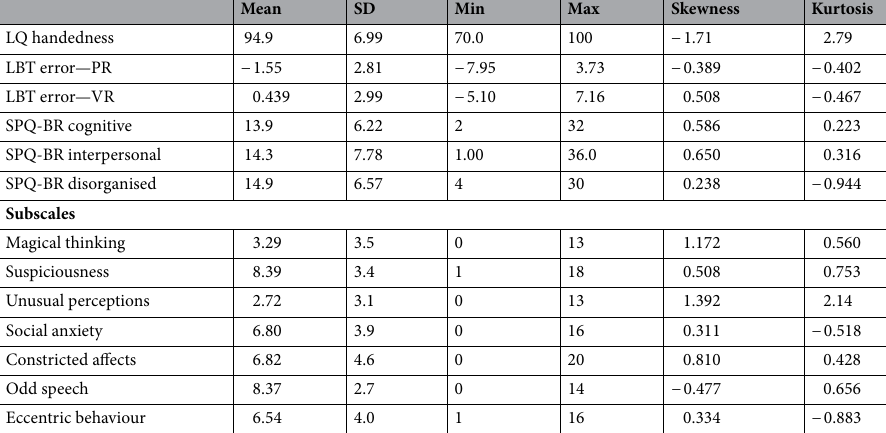
Table 1. Descriptive statistics of the measured variables (N = 51). Abbreviations: Handedness Laterality Quotient (LQ). Line Bisection Task error bias (negative scores indicate a leftward bias and the positive scores indicate a rightward bias from the middle point of the test line), physical reality (PR), virtual reality (VR), Schizotypy Personality Questionnaire Brief Revised (SPQ-BR), and the Cognitive (involving magical thinking, ideas of reference/suspiciousness, unusual perceptions subscales), Interpersonal (involving excessive social anxiety, no close friends/constricted affects subscales), Disorganised (involving odd speech and eccentric behaviour